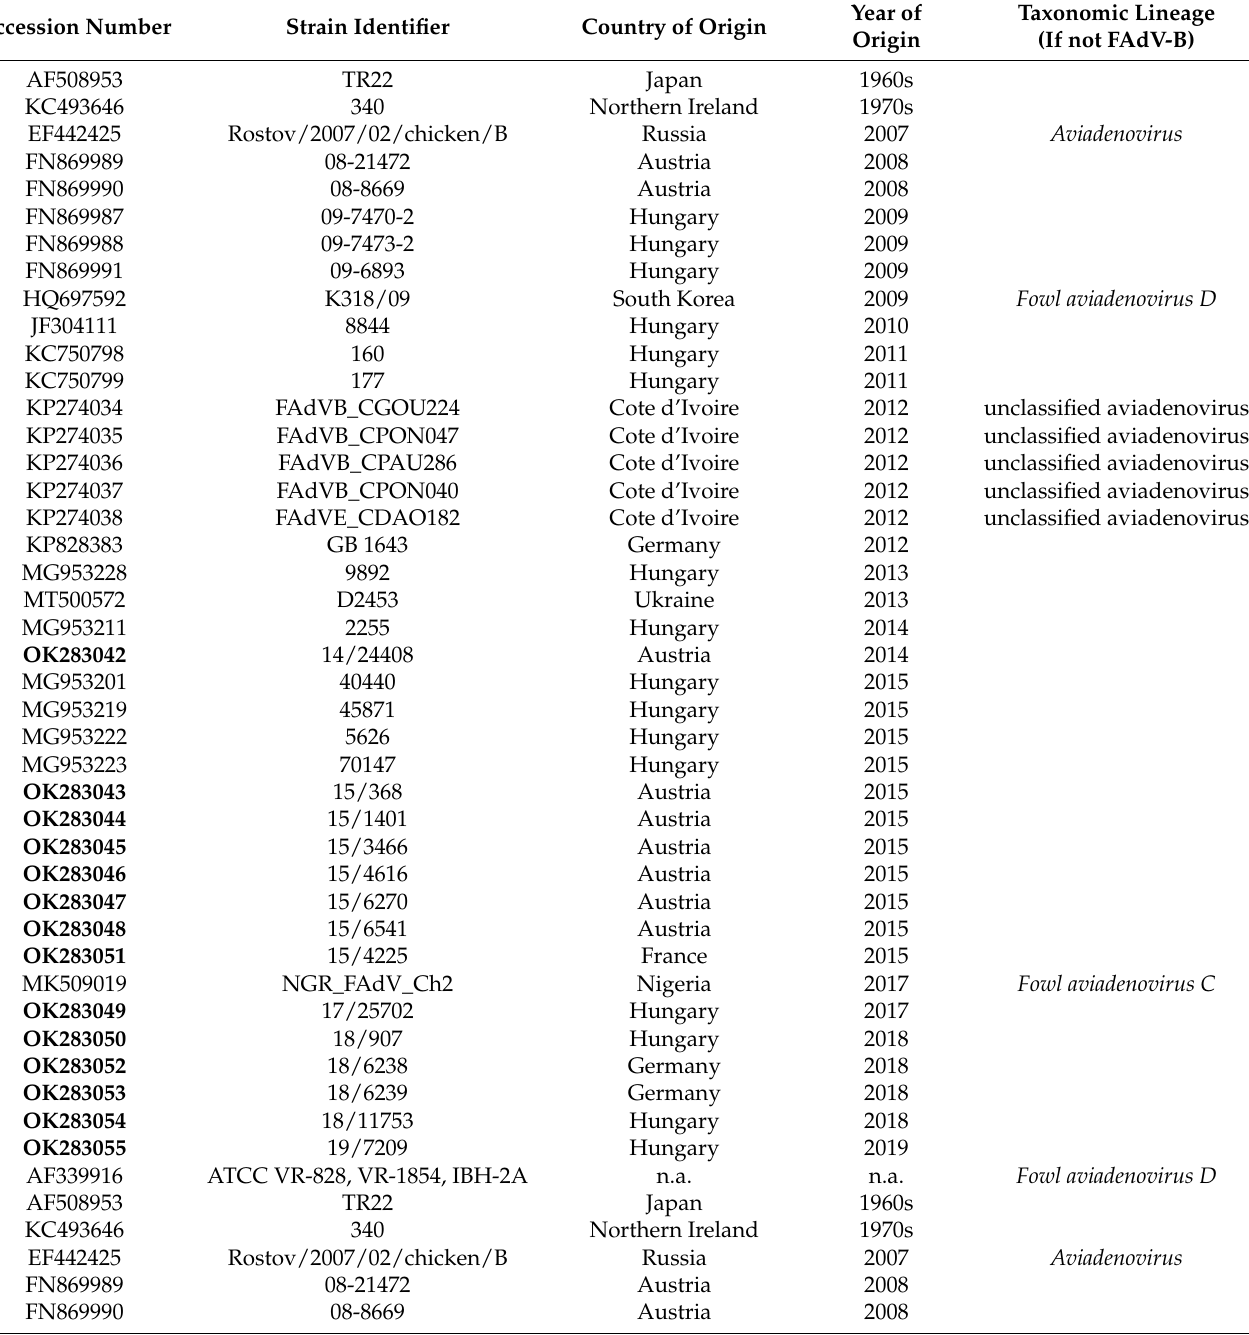
Table 2. Fowl aviadenovirus B strains, phylogenetically analyzed based on their hexon loop-1 nu- cleotide sequences. The accession numbers of the newly sequenced strains are given in